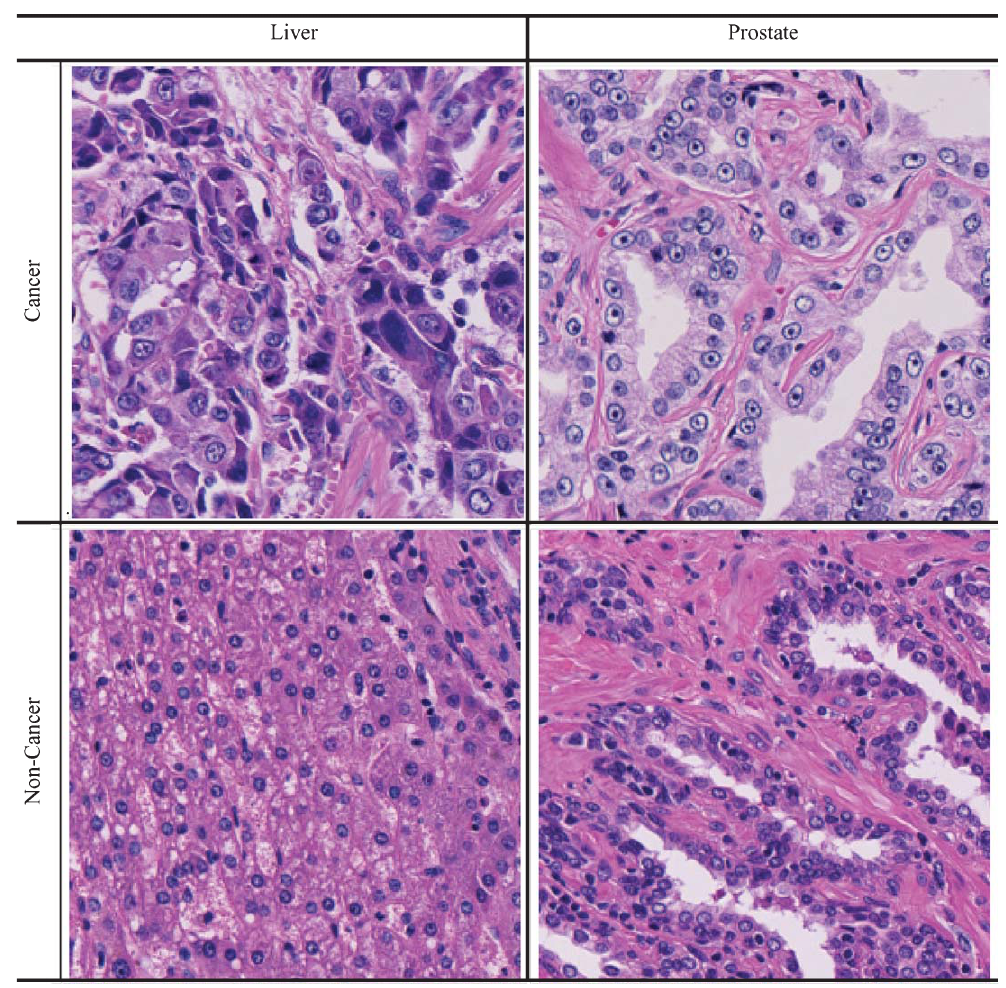
Fig. 1. Histologic texture of cancer and non-cancer regions of liver and